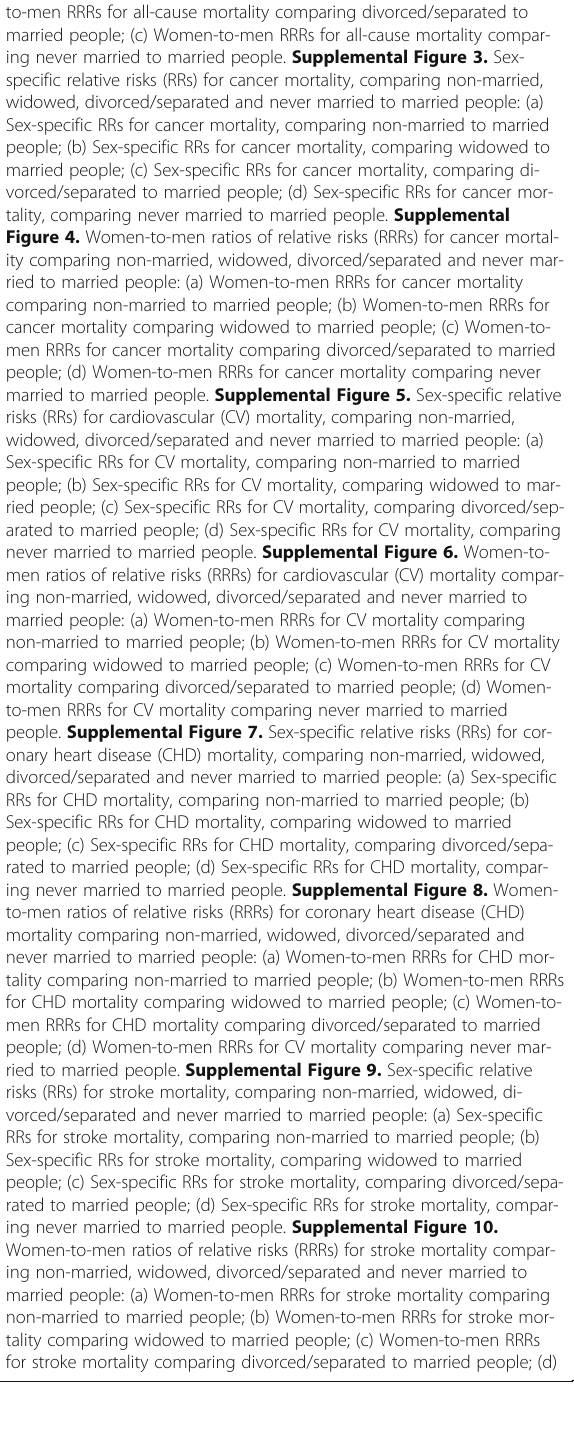
age at baseline for pooled women-to-men ratios of relative risk for risk of all-cause mortality comparing non-married people to married people. Supplemental Figure 12. Subgroup analyses for all-cause mortality for pooled women-to-men ratios of relative risk (RRRs) for risk of all-cause mortality comparing widowed people to married people. Supplemental Figure 13. Begg ’ s publication bias plot for the pooled ratio of women- to-men relative risks: (a) Begg ’ s publication bias plot for CHD mortality in divorced/separated group; (b) Begg ’ s publication bias plot for all-cause mortality in widowed group; (c) Begg ’ s publication bias plot for all-cause mortality in never married group; Abbreviations: CHD: coronary heart